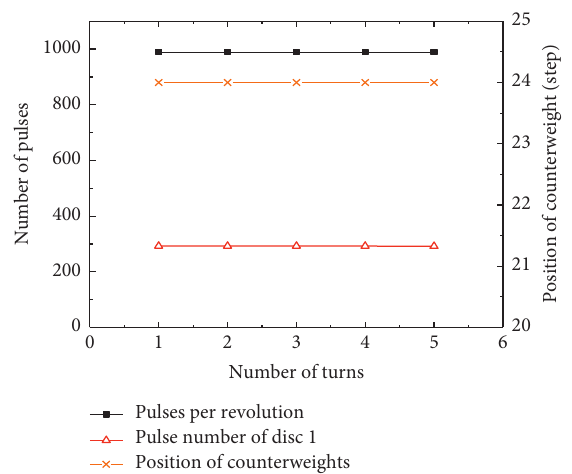
Figure 10: Position result of the optimized pulse-counting